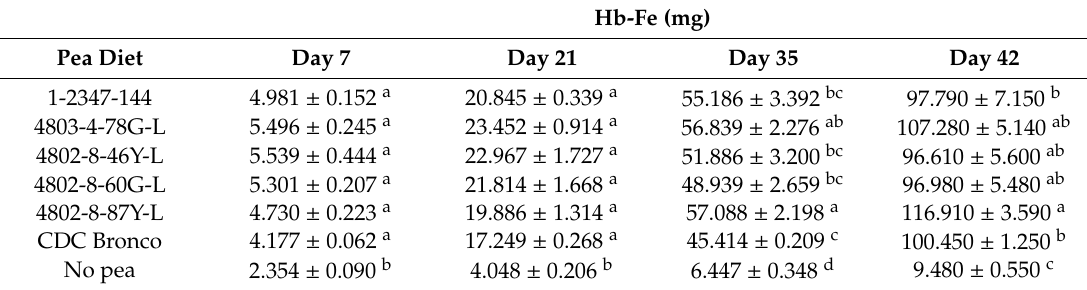
Table 7. Experimental total body hemoglobin iron (Hb-Fe) 1